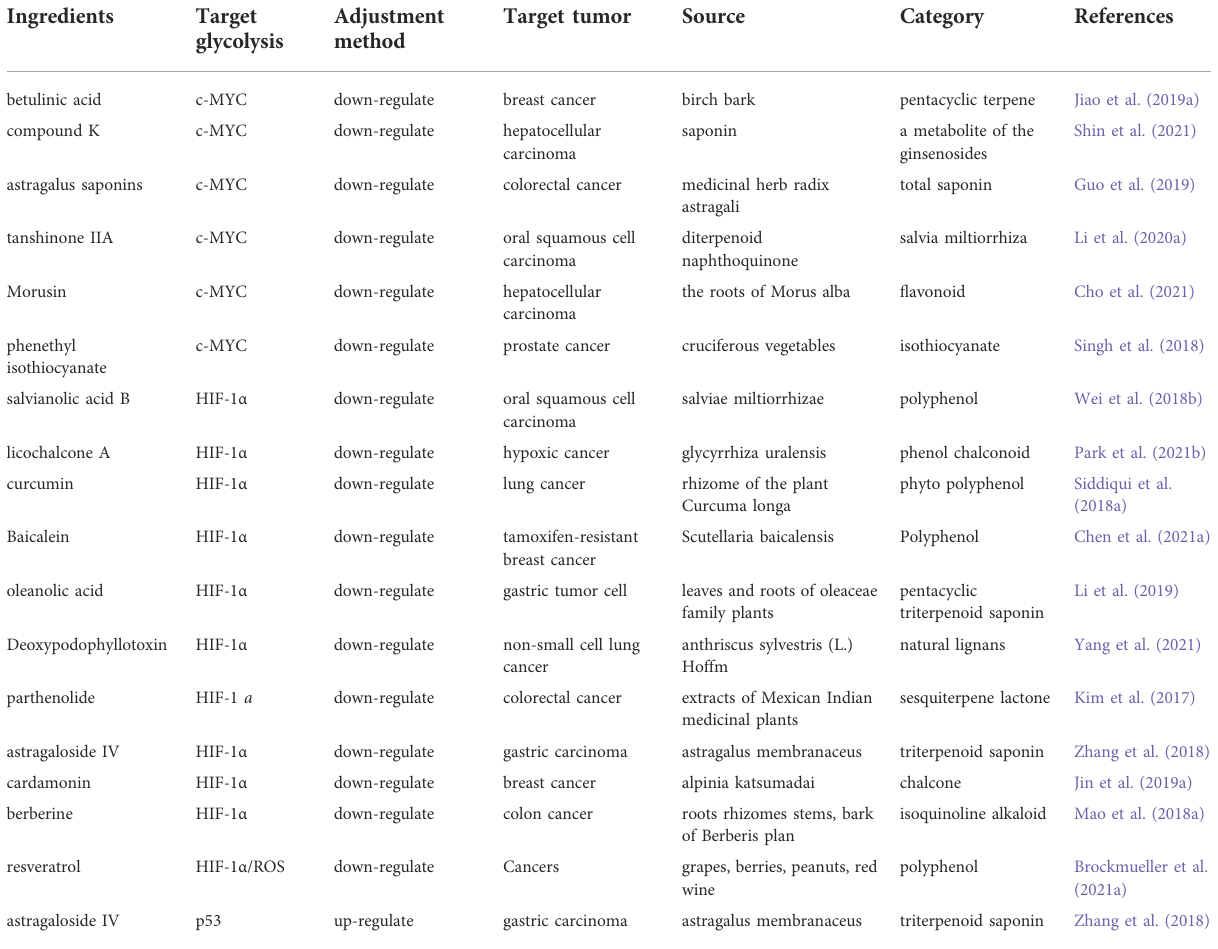
TABLE 4 Natural products regulate glycolysis via oncogenes in